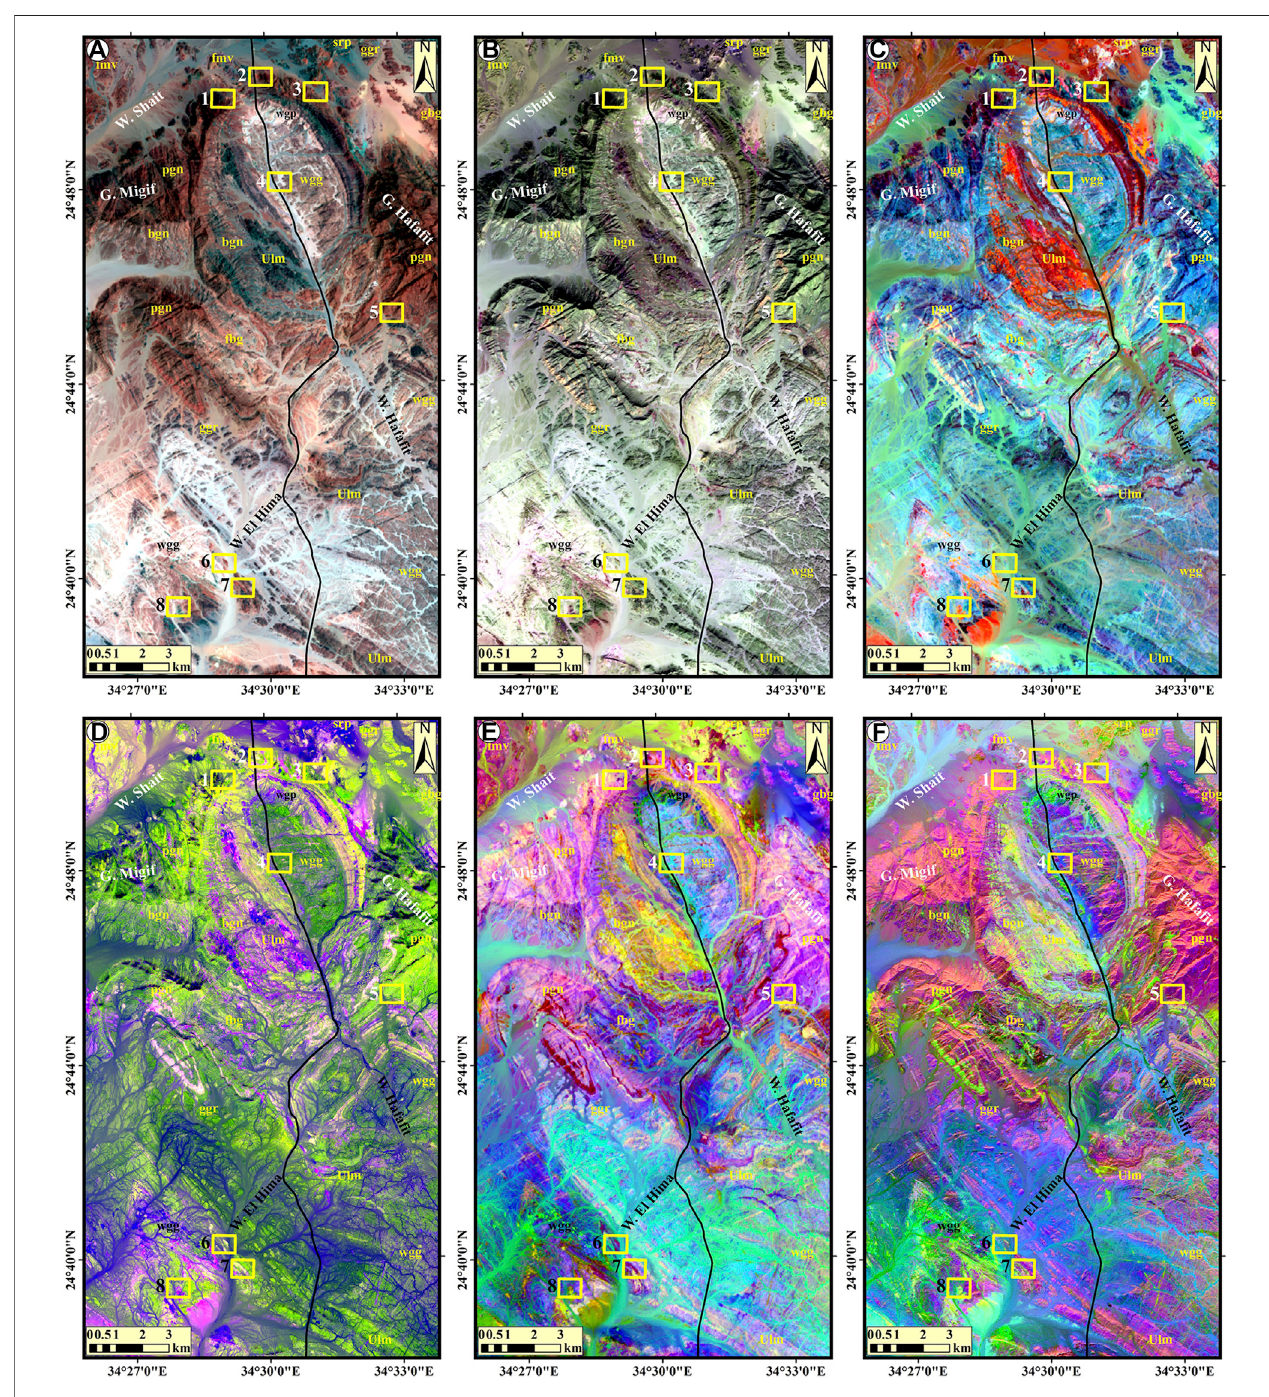
FIGURE4| Lithologicaldiscriminationbasedon (A) Landsat-8(RGB-327), (B) Sentinel-2A(RGB-3212), (C) Landsat-8(RGB-6/7,4/3,5/4), (D) Sentinel-2A(RGB- 11/7, 12/5, 11/12), (E) Landsat-8 PCA123 and (F) Sentinel-2A PCA145. The yellow boxes represent the selected areas. For abbreviations, see the legend of Figure 1 .